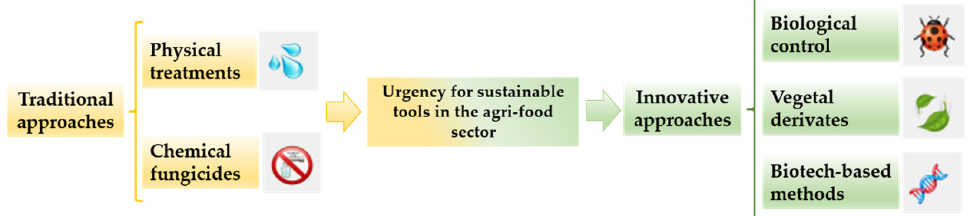
Figure 2. Approaches for post-harvest anthracnose management. Traditional strategies (yellow pan- els) and innovative methodologies explored for the improvement of the sustainability in the agri- food sector (green